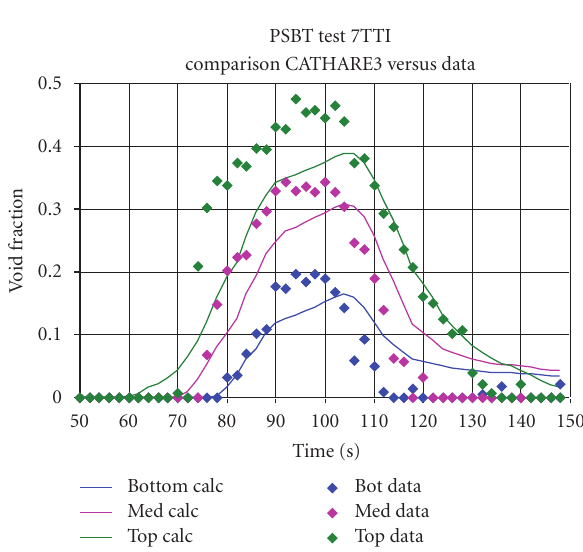
Figure 9: Comparison of void fraction transient predicted by CATHARE 3 and measured in PSBT 7TTI